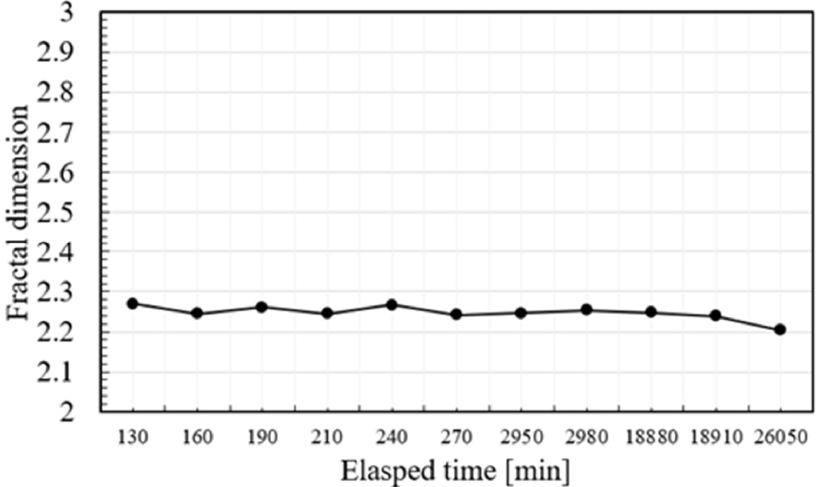
Figure 9. Variation of the fractal dimension measured from a SEM image of a test-piece exposed to air with exposure time.